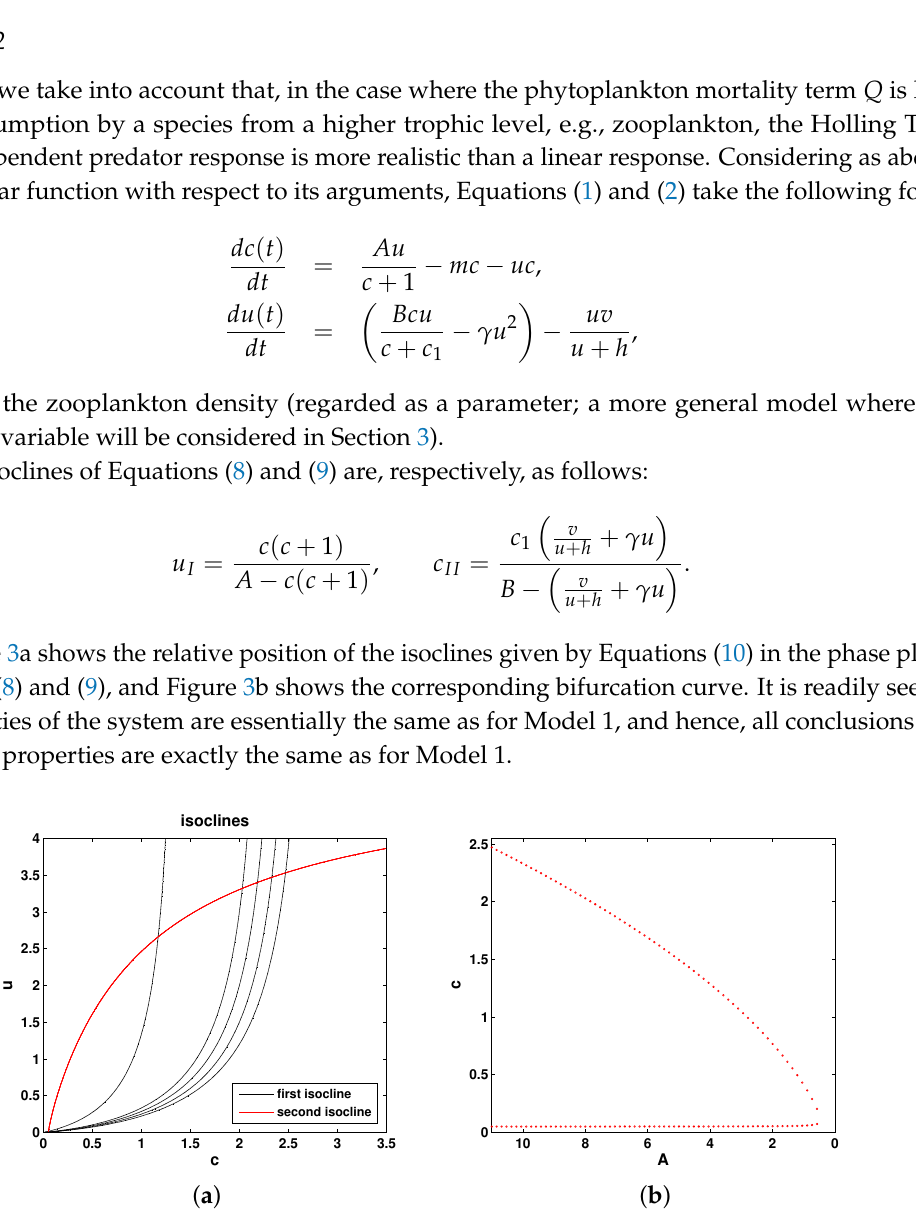
Figure 3. ( a ) The (null-)isoclines of the oxygen-phytoplankton system for Model 2. Black curves show the oxygen isocline ( u I ) for A = 3.5,8,9,10 and 11 (from left to right, respectively), and the red curve shows the phytoplankton isocline ( c II ). ( b ) Positive steady states of Equations (8) and (9) shown as functions of A . Here, v = 0.3, and other parameters are the same as in Figure